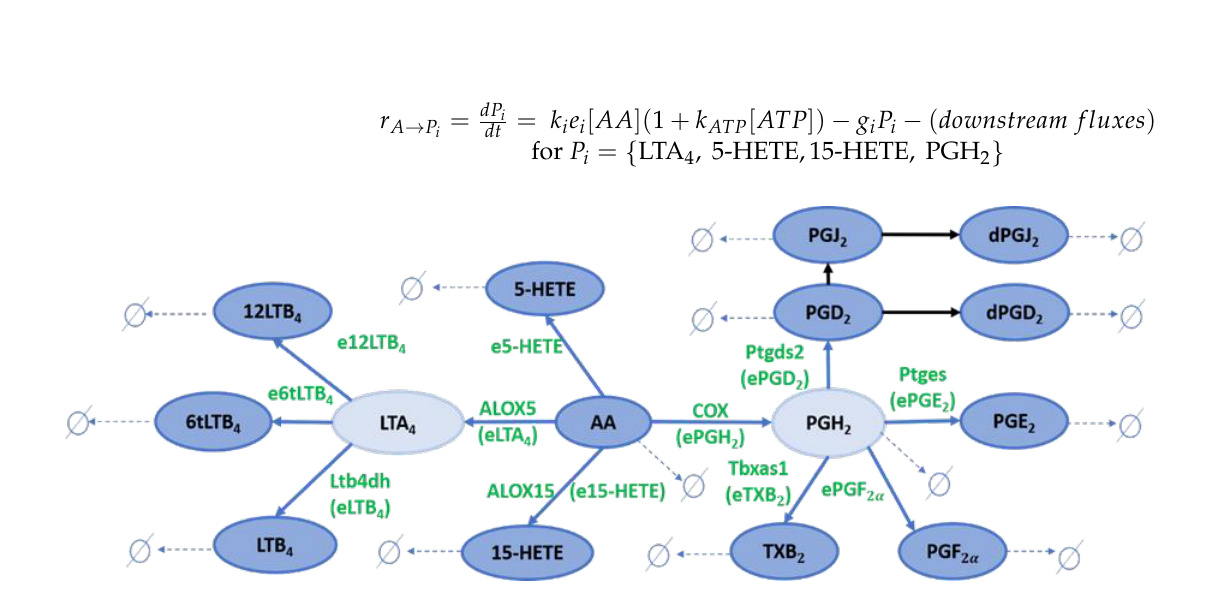
Figure 1. The arachidonic acid (AA) metabolic pathway map for the breakdown of arachidonic acid into respective products prostanoid and leukotriene via prostaglandin H2 (PGH 2 ) and leukotriene A4 (LTA 4 ) is shown: (green) enzymes, (ellipses) lipid metabolites, (shaded) measured metabolites, (blue arrows) enzymatic and (black arrows) non-enzymatic reactions. The Hydroxyeicosatetraenoic acid (HETE) metabolites 5-HETE and 15-HETE are also formed from AA.